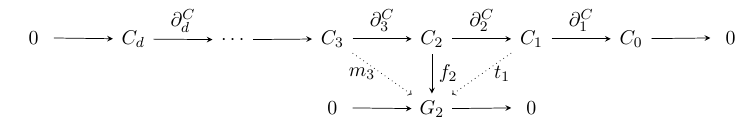
Figure 7 . Chain complexes that de(cid:12)ne Abelian 1-gauge theories in d dimensions with degrees of freedom living at the faces of the lattice. f 2 are the con(cid:12)gurations, t 1 are the gauge transformations labeled by links, and there is also m 3 as the